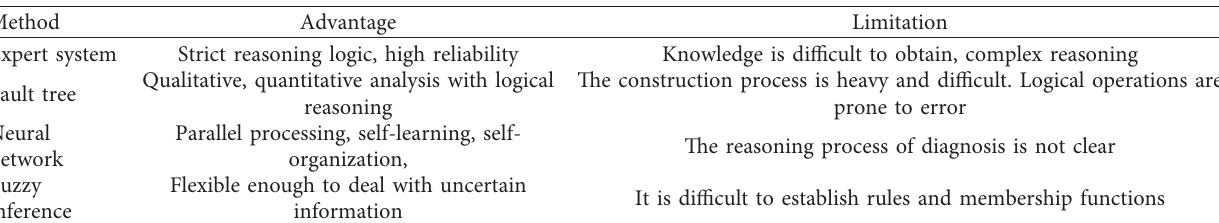
Table 2: Active surface fault diagnosis method based on artificial intelligence